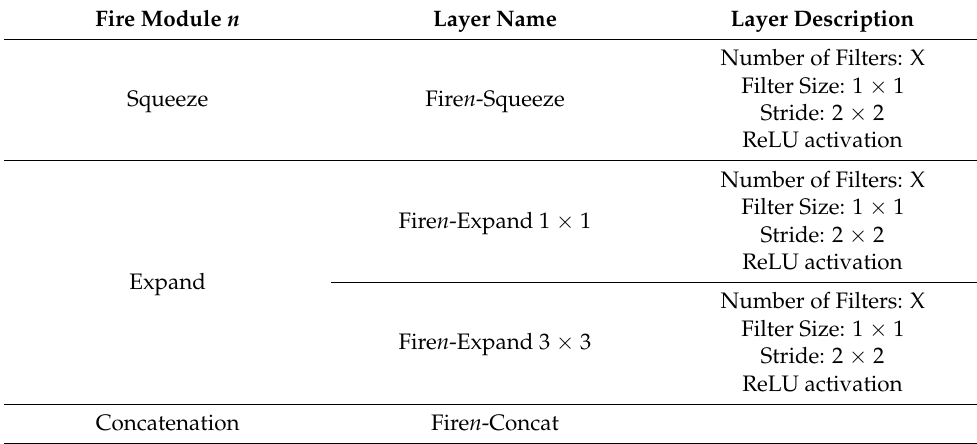
Table 2. Typical fire module consisting of squeeze and expand convolutional layers.